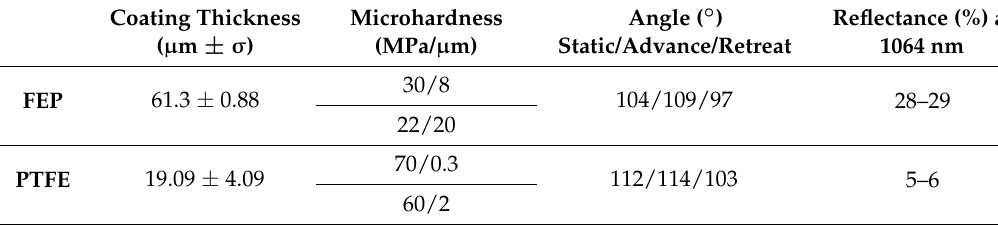
Table 3. Summary of physical properties on FEP and PTFE applied on substrates of EN AW